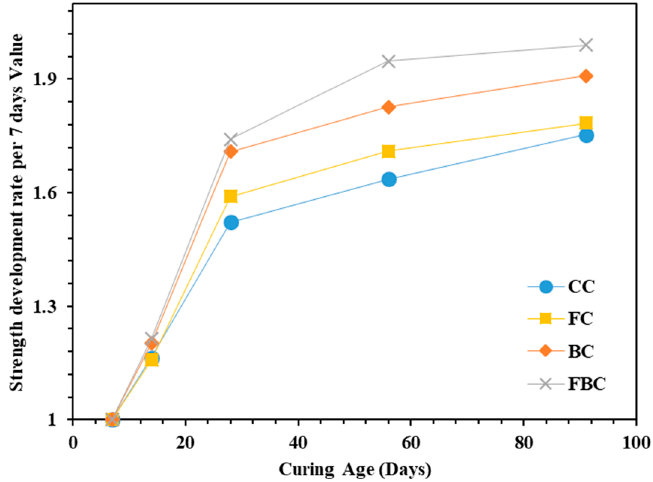
Figure 4. Strength development rate for mass concrete samples containing FA and BT.